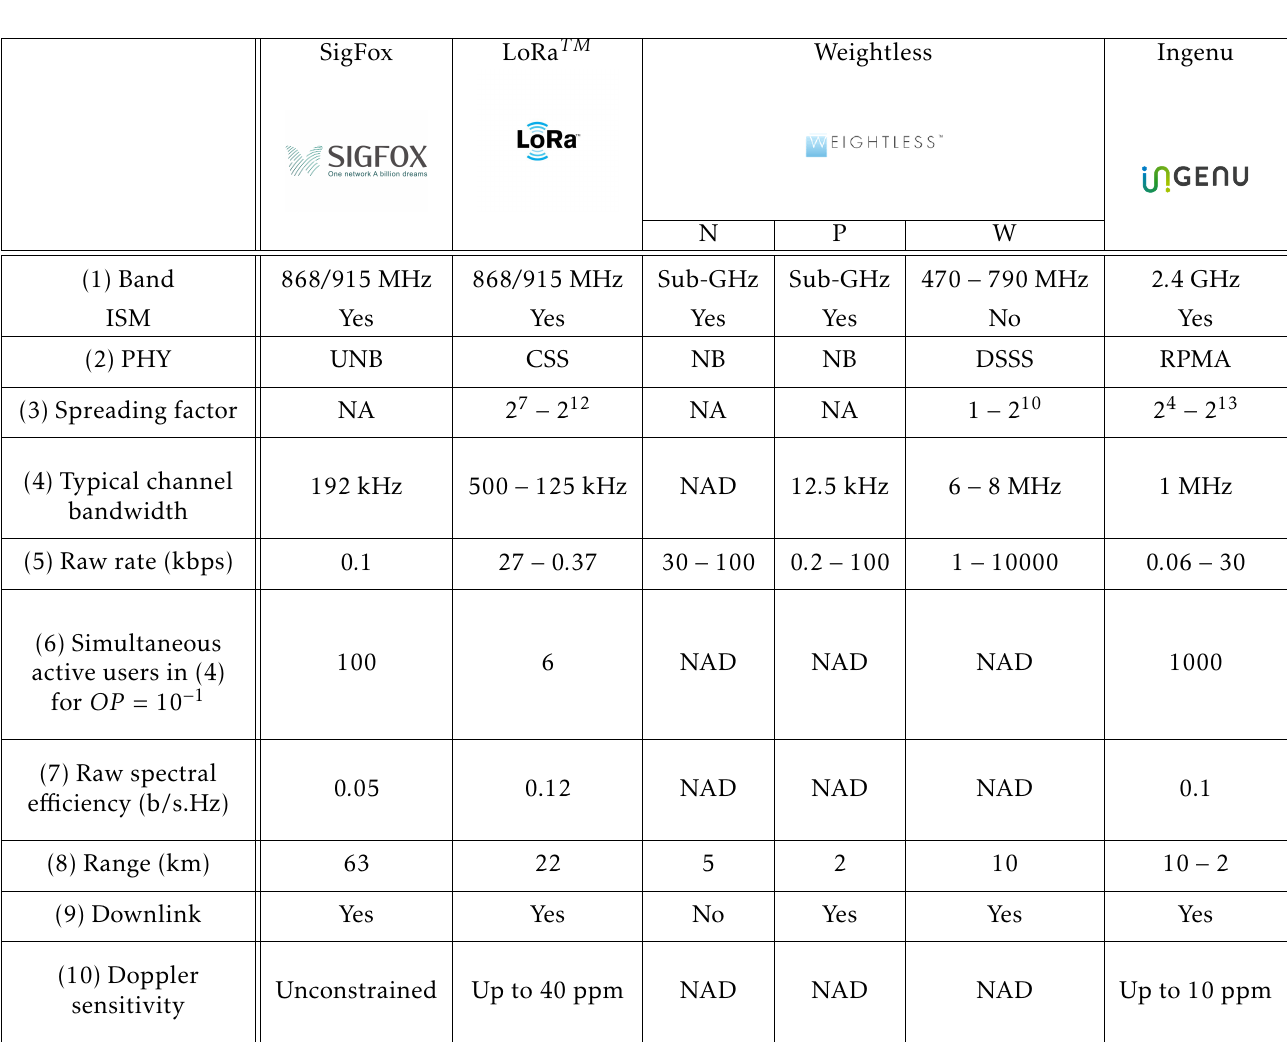
bursty access, with very small packets but under high QoS constraints such as high reliability or low